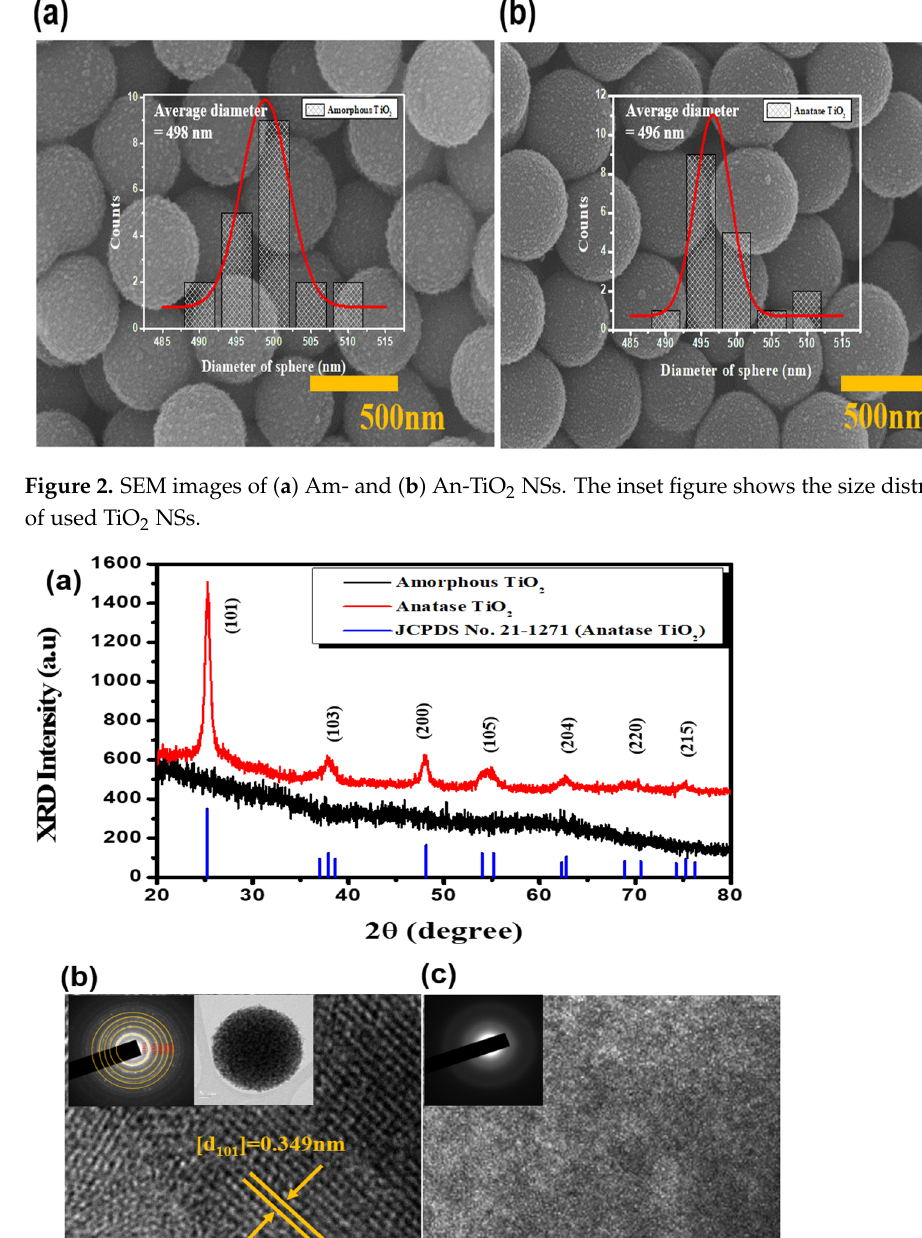
Figure 2. SEM images of ( a ) Am- and ( b ) An-TiO 2 NSs. The inset figure shows the size distributions of used TiO 2 NSs.